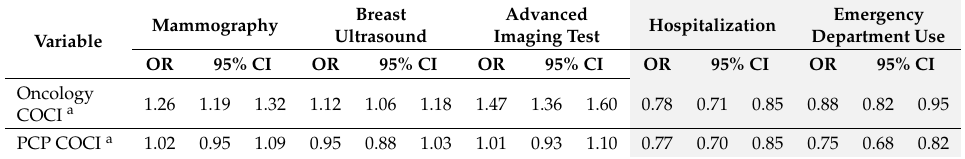
Table 4. Generalized estimating equation models for the e ff ect of continuity of